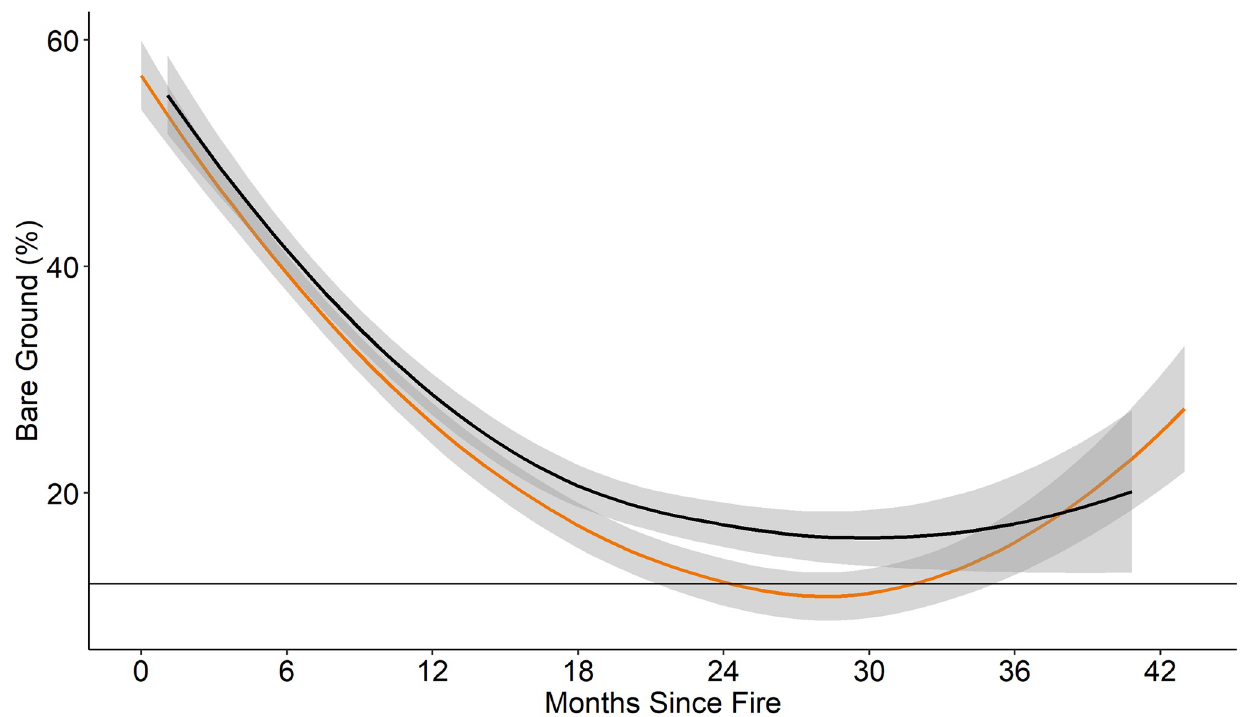
Fig 4. Percent bare ground. Percent bare ground for fire-only (orange) and pyric herbivory (black) treatments at all sites from 2014 to 2016. Shaded area indicates 95% confidence interval. Horizontal line represents the minimum amount of bare ground (12%) reported for areas used by prairie-chicken broods. � Regression lines and confidence intervals generated using “loess” locally-weighted smoothing function.